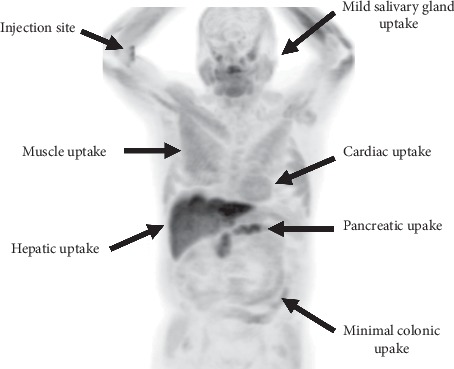
Physiologic uptake of 18F-fluciclovine. This is an MIP view from a negative study. Additional sites of physiologic/benign 18F-fluciclovine uptake may occur in the pituitary gland, the kidneys, ureters, bladder, ganglia, and adrenals. Note the absence of bladder activity in this patient.